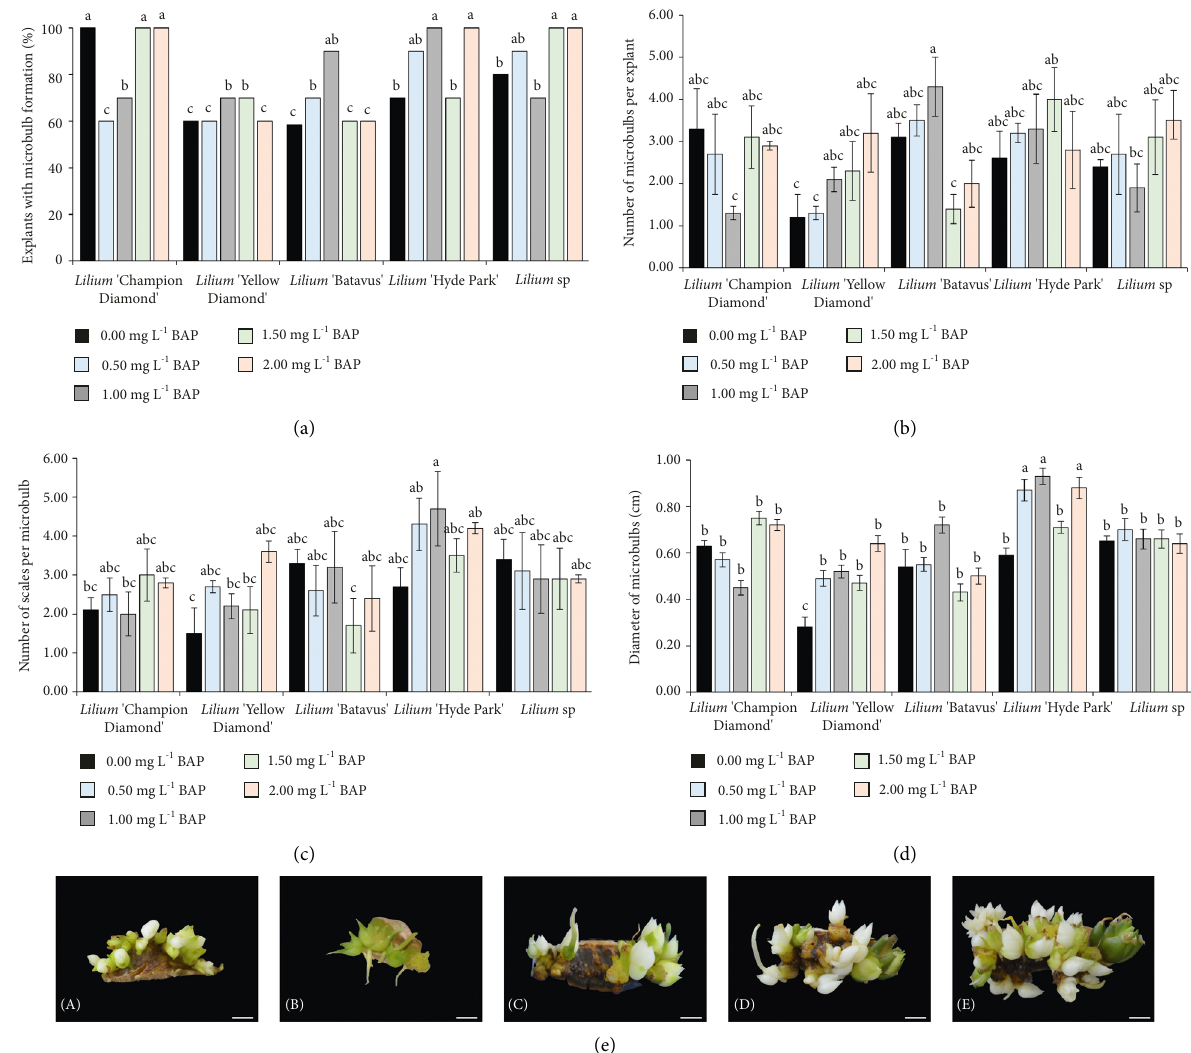
Figure 1: Effects of different concentrations of benzylaminopurine on microbulb regeneration from bulb scales. The panels are (a) percentage of explants with microbulb formation, (b) number of microbulbs per explant, (c) number of scales per microbulb, (d) microbulb diameter, and (e) microbulb regeneration in five lily cultivars. (A) Lilium “Yellow Diamond,” (B) Lilium sp., (C) Lilium “Champion Diamond,” (D) Lilium “Hyde Park,” and (E) Lilium “Batavus.” Scale � 50mm. Table 1: Comparison of morphological (growth) characteristics of five varieties of lilies grown from in vitro regeneration of microbulbs. Equatorial Plant height Diameter of No. of leaves per Bulb fresh Polar diameter Varieties of lily diameter of bulb No. of bulbs (cm) stem (cm) plant weight (g) of bulb (cm) (cm) Lilium “Batavus” 84.20 ± 8.84 b Lilium “Champion Diamond” Lilium “Hyde Lilium “Yellow Means ( ± standard deviation) with the same letter in the column do not differ significantly from each other (Tukey, p ≤ 0 .